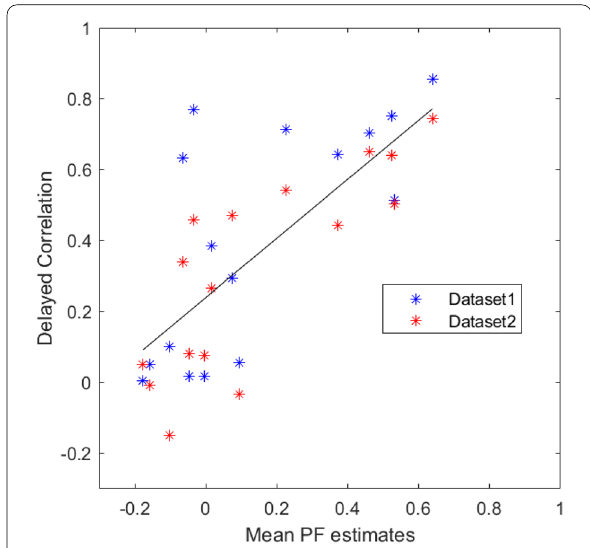
Fig. 6 Scatter plot showing the relationship between mean PF estimates (horizontal axis) and delayed correlation (vertical axis) on the two sensory-motor experiments. On both results taken altogether the Pearson’s correlation coefficient ρ is 0.74, which corresponds to a statistically significant correlation with p < 0.001 . Slope and offset of the linear fit were 0.83 and 0.24 respectively